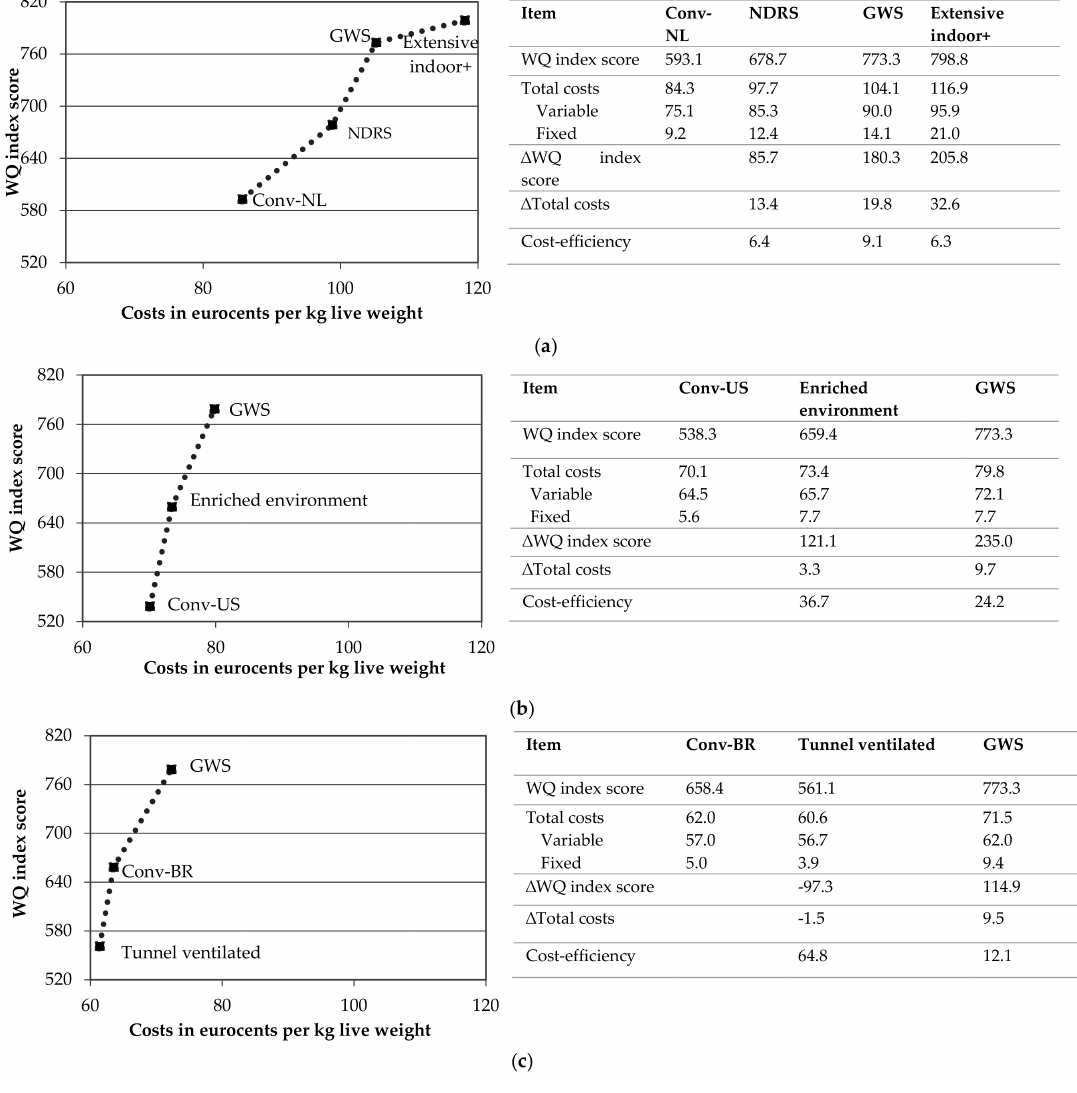
Figure 2. Cost-e ffi ciency of production systems in ( a ) the Netherlands ( b ) United States and ( c )